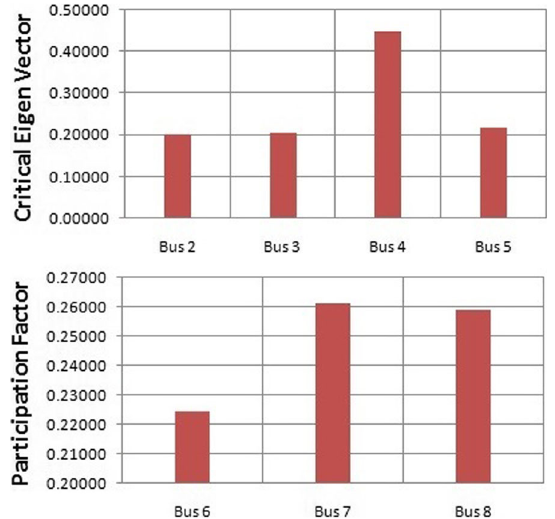
Fig. 14 Critical eigen vector entry and participation